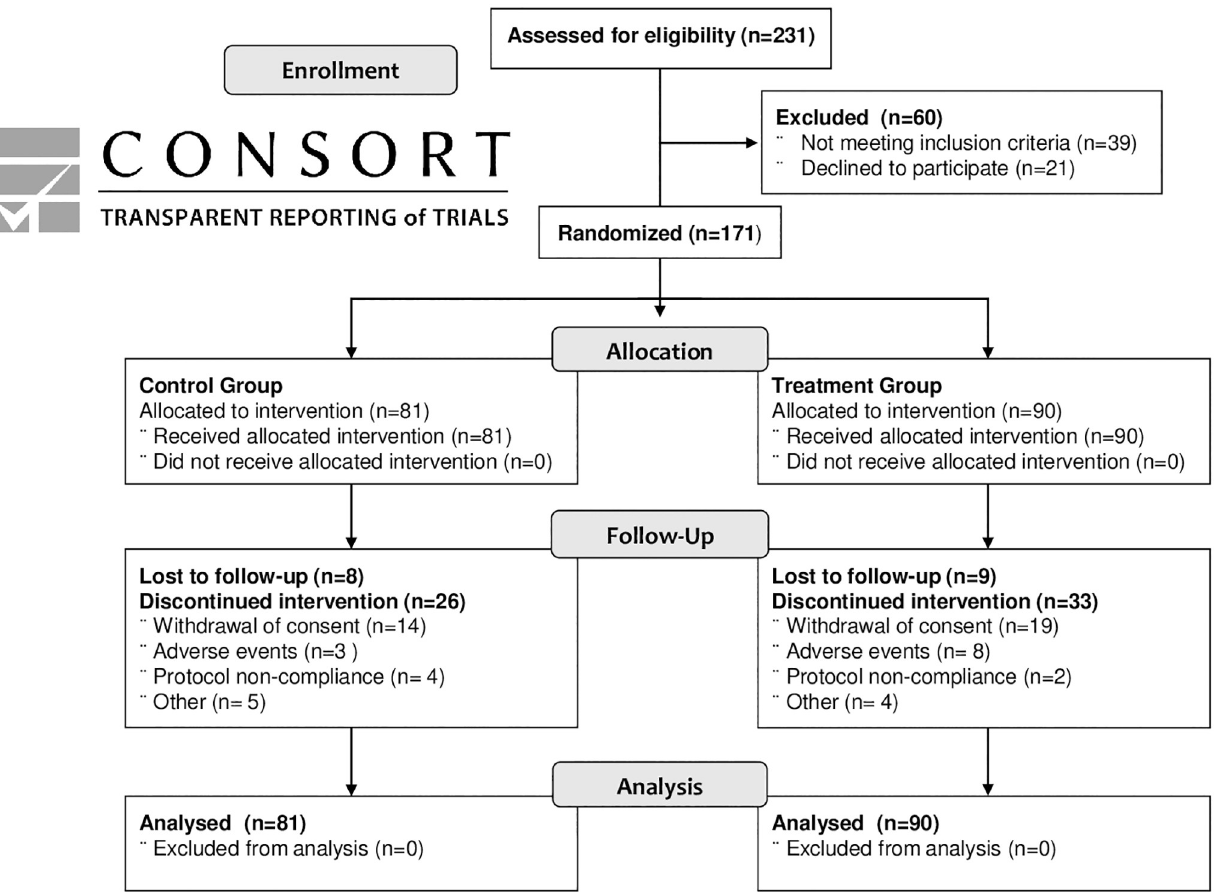
Fig 1. CONSORT flow diagram. Enrollment, eligibility screening, allocation, follow-up, and analysis of participants in the MAINTAIN Randomized Controlled Trial.